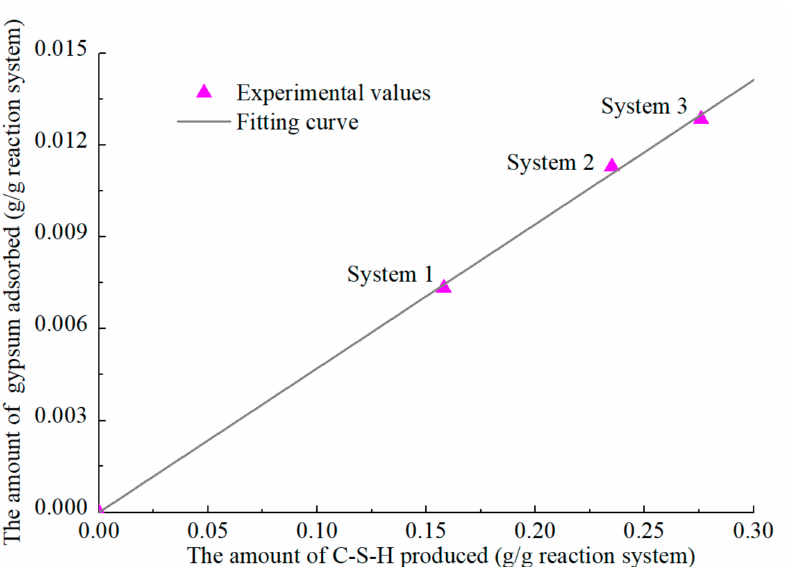
Figure 20. Relationship between the amount of C-S-H produced and the gypsum absorbed in the Alite-C 3 A-gypsum